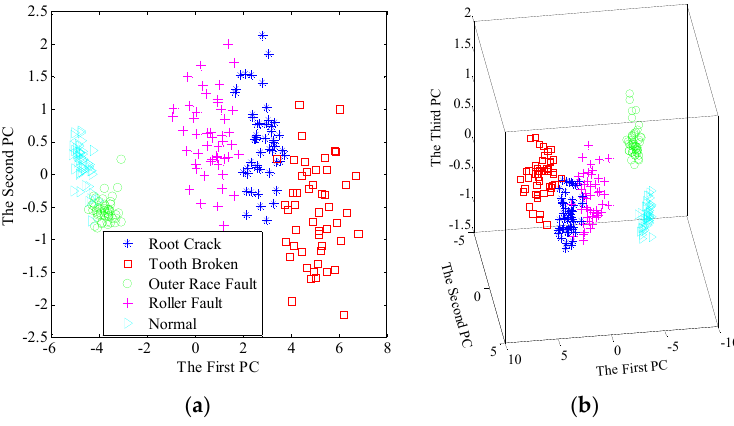
Figure 16. Scatter plots of the principal components after dimensionality reduction using EMD and SVD: ( a ) The first two principal components; ( b ) The first three principal